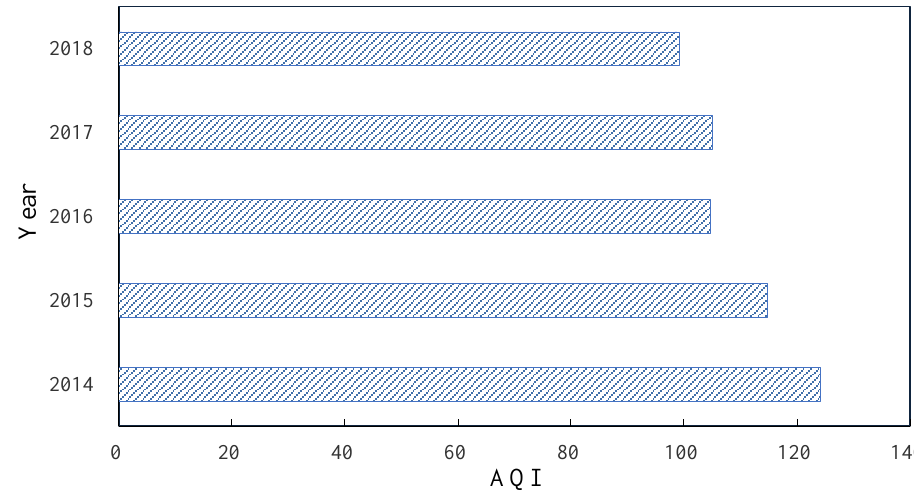
Figure 2. Annual average of the AQI in Weifang from 2014 – 2018.